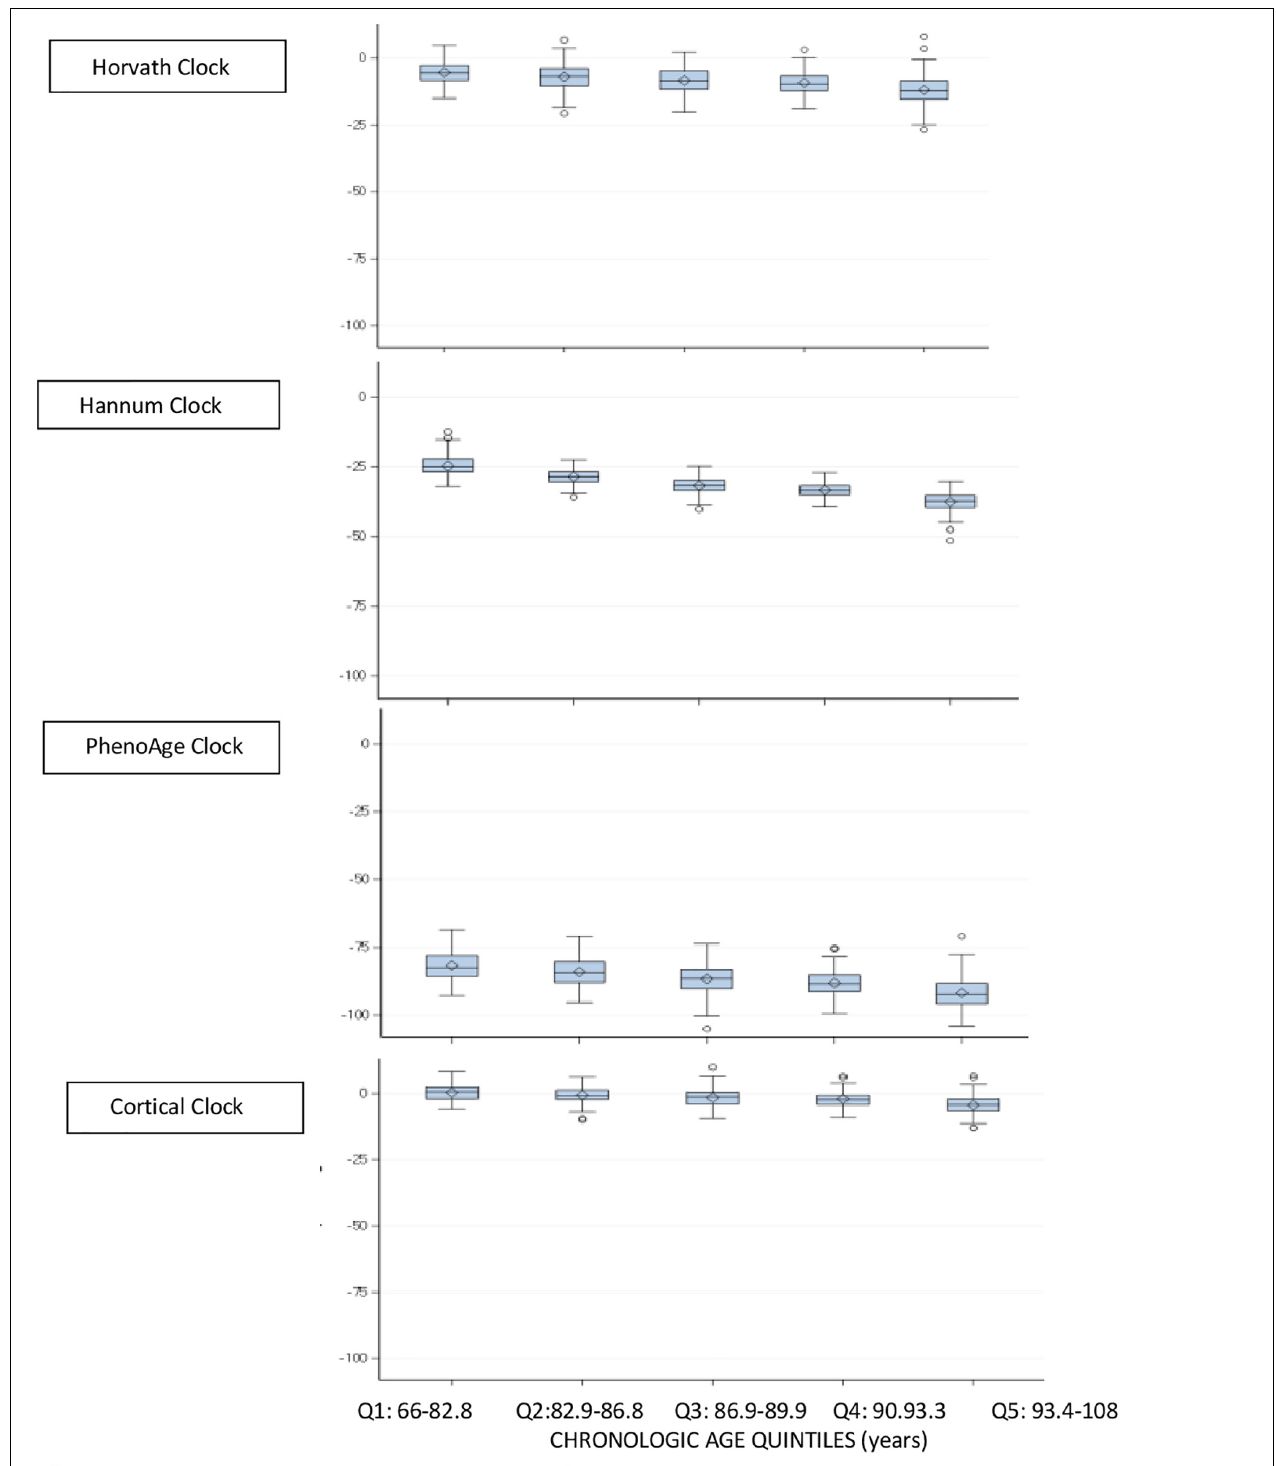
FIGURE 1 | Difference between epigenetic clock age and chronologic age a , within quintiles of chronologic age, in dorsolateral prefrontal cortex.